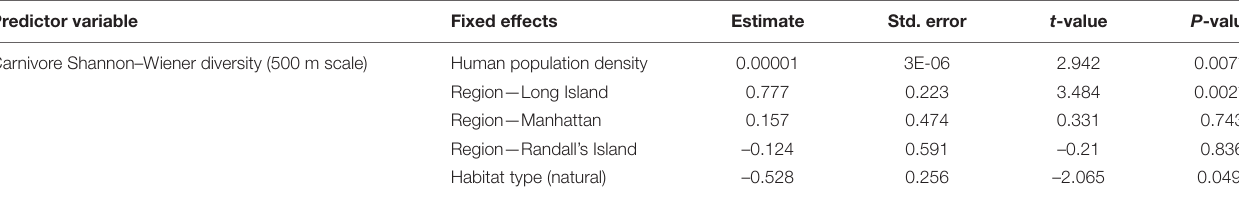
FIGURE 5 | Patterns among Carnivore taxa diversity (Shannon–Wiener index) and (A) human population density; (B) region; and (C) habitat type across the 31 study sites. Points and whiskers on the plot represent the mean and standard error. TABLE 6 | Best supported model for Carnivore Shannon–Wiener diversity (500 m scale) based on averaging of parameter estimates. Predictor variable Fixed effects Estimate Std. error t -value P